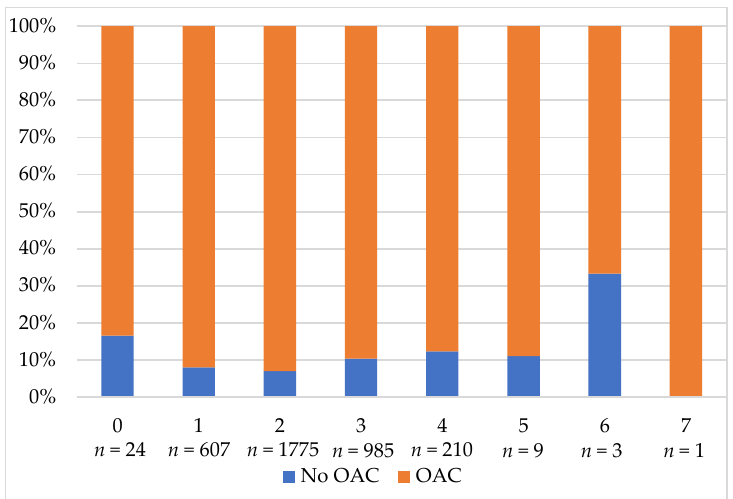
Figure 3. The prescription of OAC based on the HAS-BLED score. Abbreviation: OAC, oral antico- agulant.